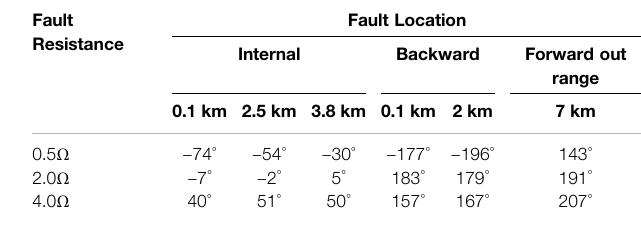
TABLE 2 | Simulation Result of Phase-to-Phase fault occurring under the protection operation in sending